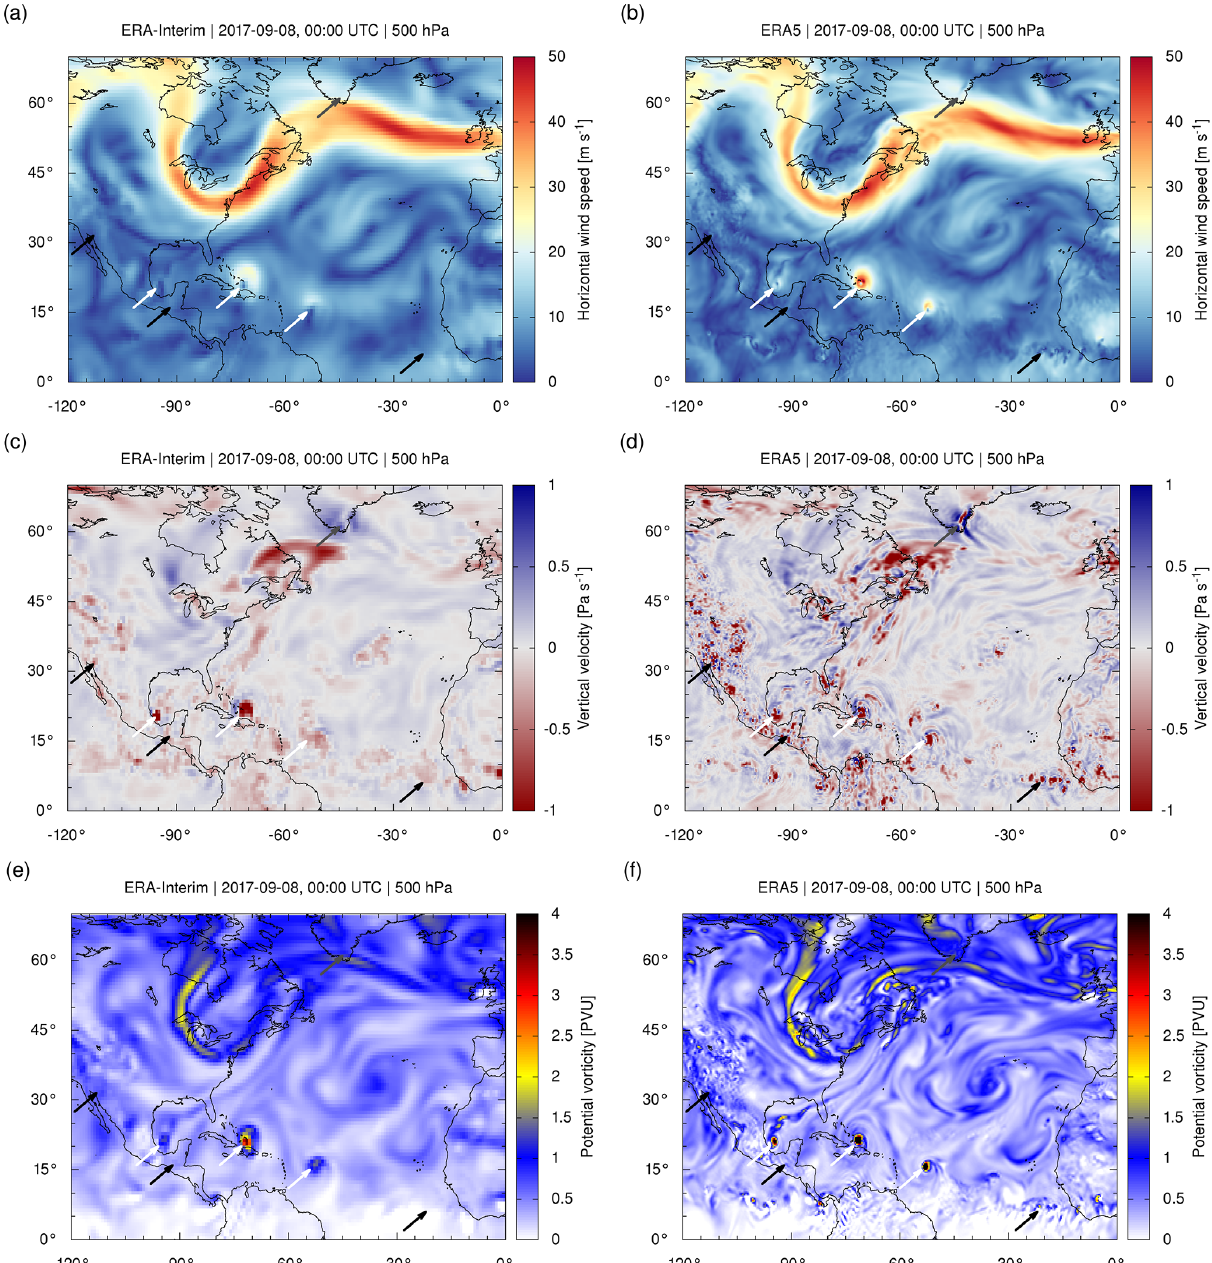
Figure 2. Comparison of ERA-Interim (a, c, e) and ERA5 (b, d, f) horizontal wind speeds (a, b) , vertical velocities (c, d) , and potential vorticities (e, f) on 8 September 2017, 00:00UTC over North America and the North Atlantic. Maps refer to the 500hPa level (an altitude of about 5km). Arrows are used to point out hurricanes Katia, Irma, and Jose (white, from west to east) as well as examples of gravity waves (gray) and explicitly resolved convective updrafts